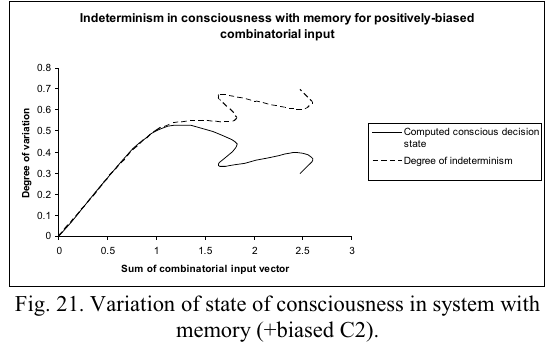
Fig. 21. Variation of state of consciousness in system with memory (+biased C2).